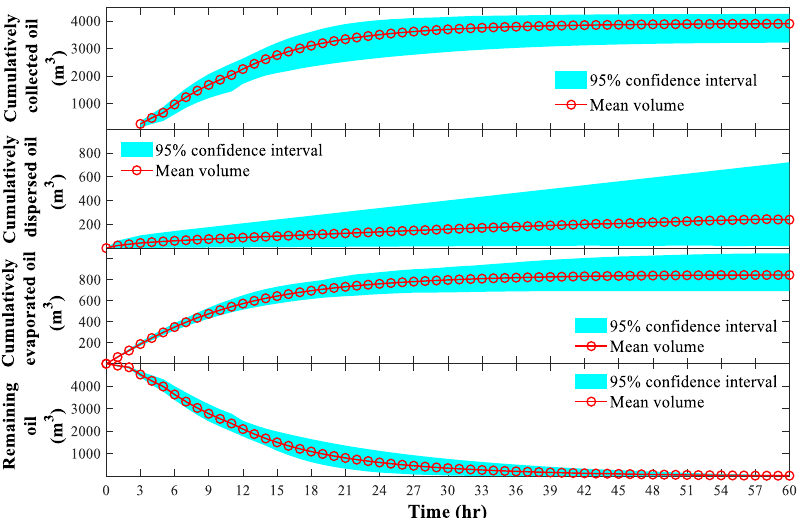
Figure 12. Simulation results of oil collection, evaporation and dispersion processes.